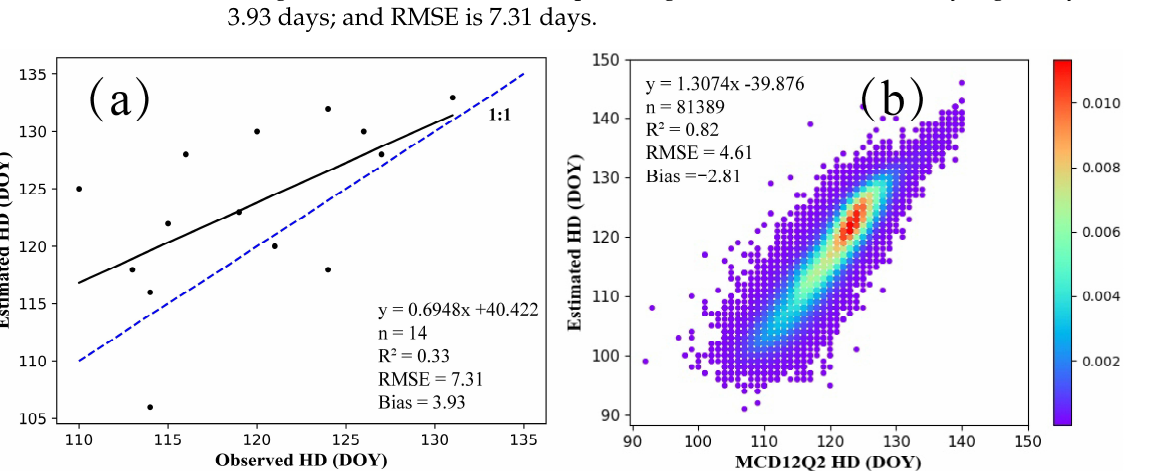
Figure 5. Spatial distribution of winter wheat MD by ( a ) prediction and ( b ) MCD12Q2 product.